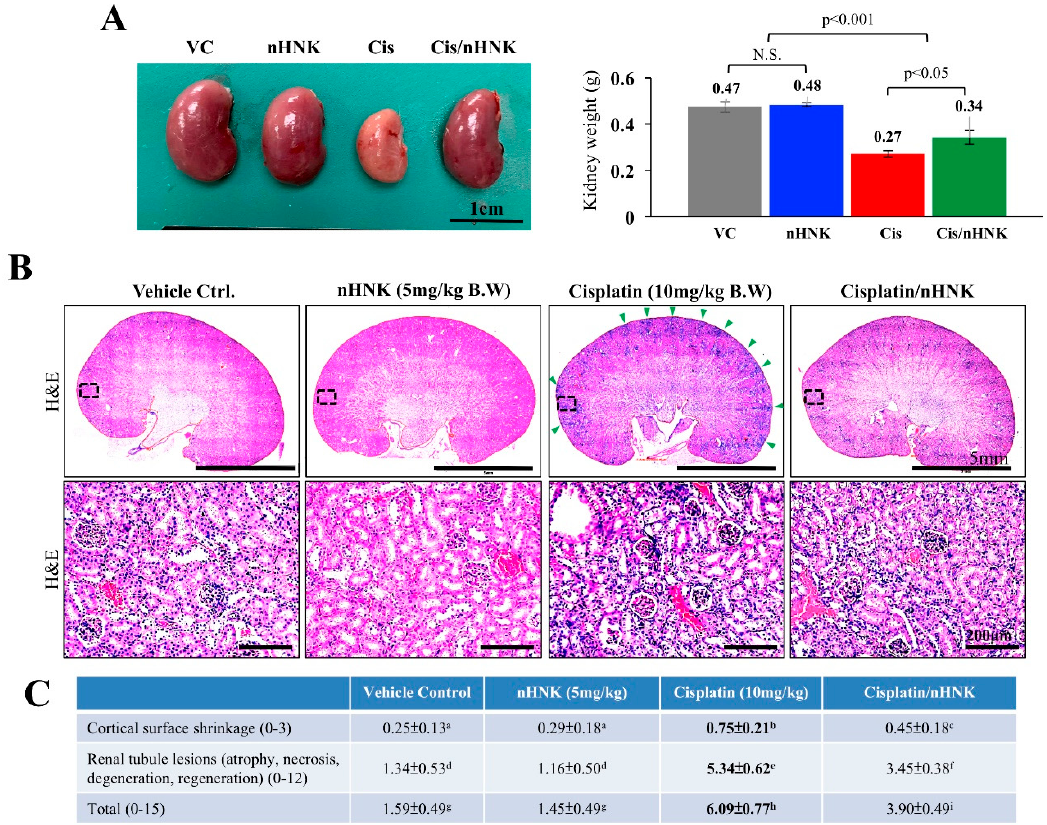
Figure 2. Histological and pathological evaluations of cisplatin-induced damages in kidney. (A) Kidneys of cisplatin-injured animals were smaller in size with pale appearance and were significantly lighter than kidneys of other groups. (B) Under hematoxylin and eosin (H and E) stain, a significant increase in the infiltration of inflammatory cells around the blood vessels and at the cortex region were observed in cisplatin-injured animals (marked with arrowheads and was enlarged with higher magnification). (C) Pathological scoring showed a basic scoring of 1.59 ± 0.49 and 1.45 ± 0.49 in control and nHNK groups while cisplatin-receiving animals scored significantly higher values of 6.09 ± 0.77 for their pathological changes in kidneys, and a significantly reduced pathological scoring of 3.90 ± 0.49 was calculated in the treatment group. Data were presented as mean ± SD, and statistical significance was set to p < 0.05 under one-way analysis of variance (ANOVA) followed by a Kruskal Wallis test, a–i indicate statistical difference between groups. Representative images are presented.